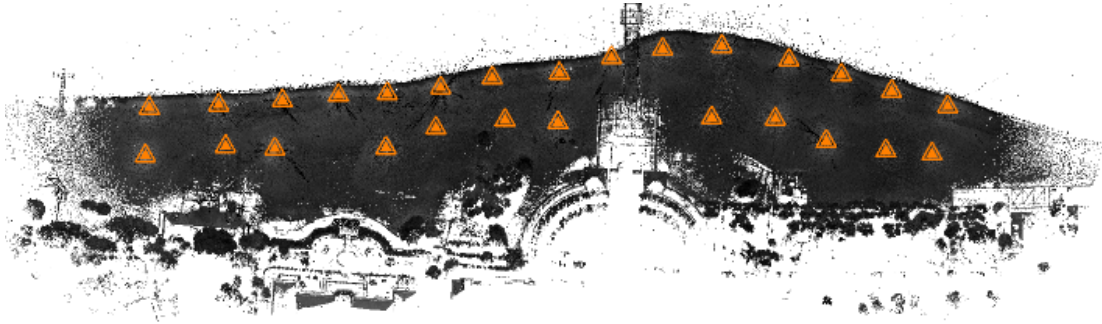
Figure 8. The location of terrestrial laser scanning (TLS) measurement sites.